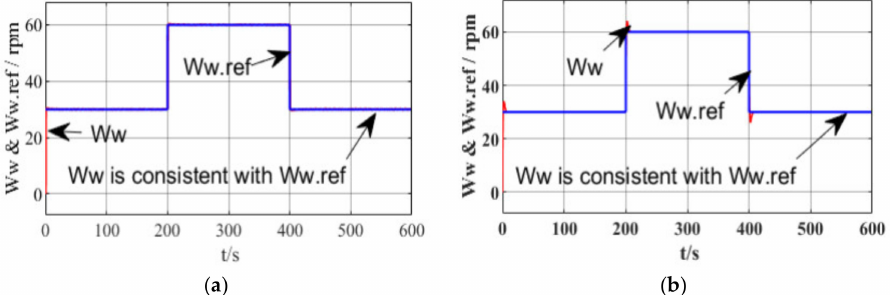
Figure 18. While α alter, the wind turbine speed waveform based on IMC. ( a ) The wind turbine speed waveform of α = 10, ( b ) The speed waveform of α = 2.